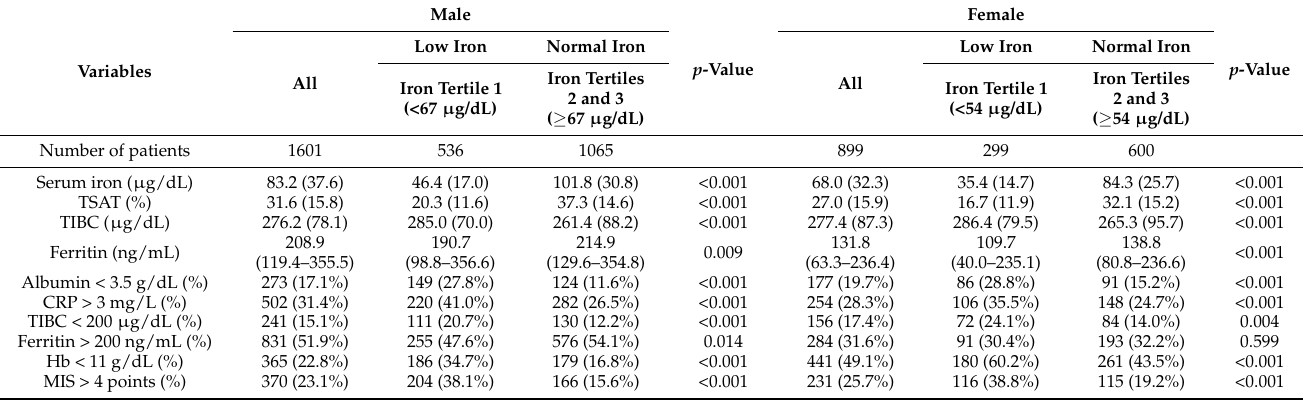
Table 2. Iron status divided by sex and serum iron in chronic kidney disease stage 1–4 patients.